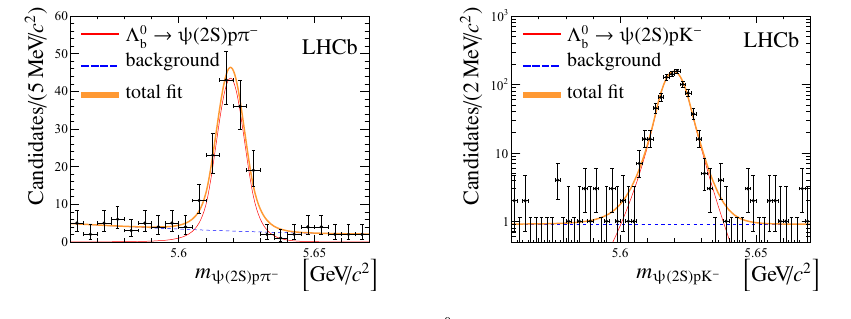
ψ (2S)p π − and (right, in logarithmic b →